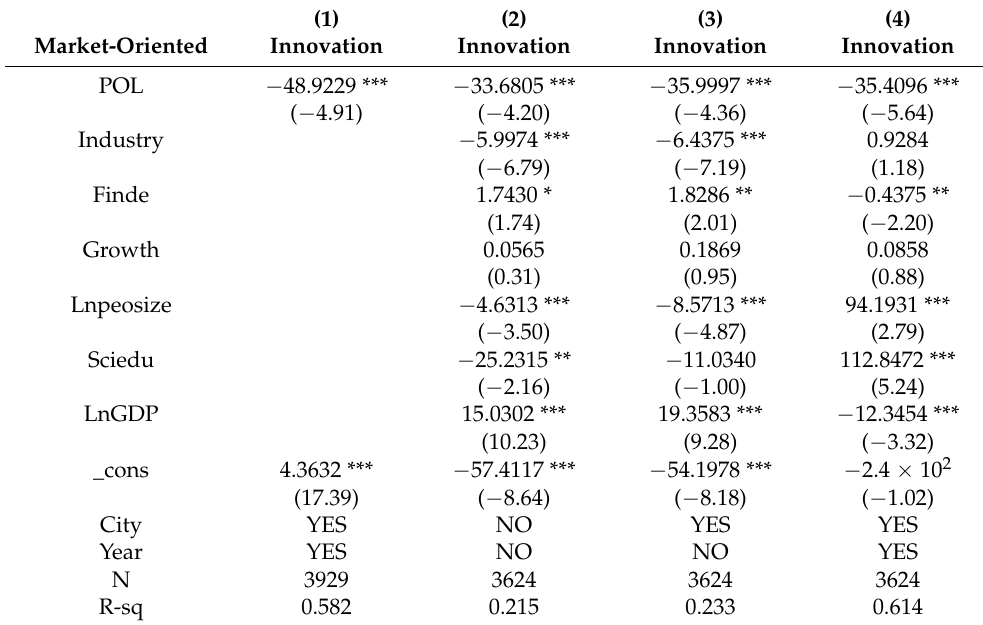
Table 10. DID regression results of market-oriented environmental regulation.